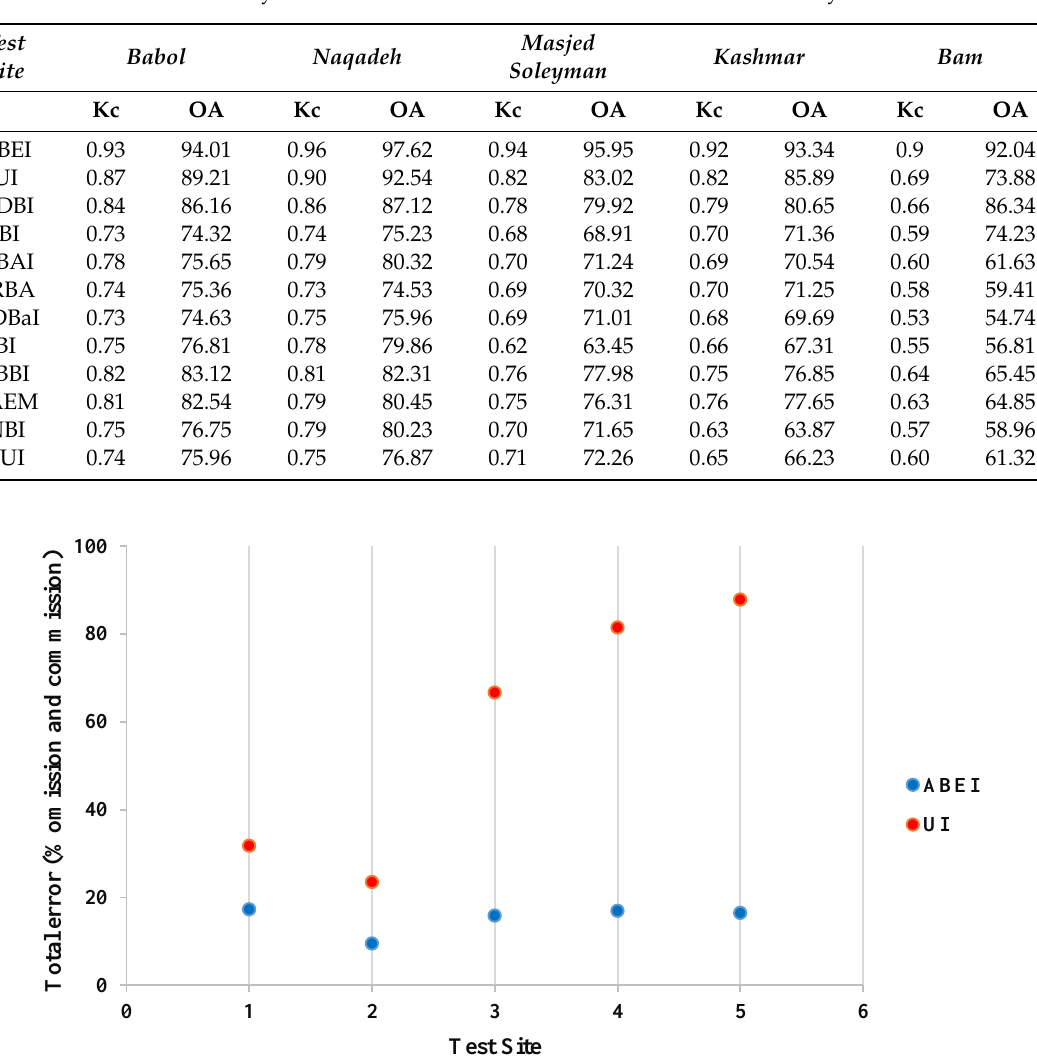
Table 3. Summary of the classification accuracies of the various methods by test site.